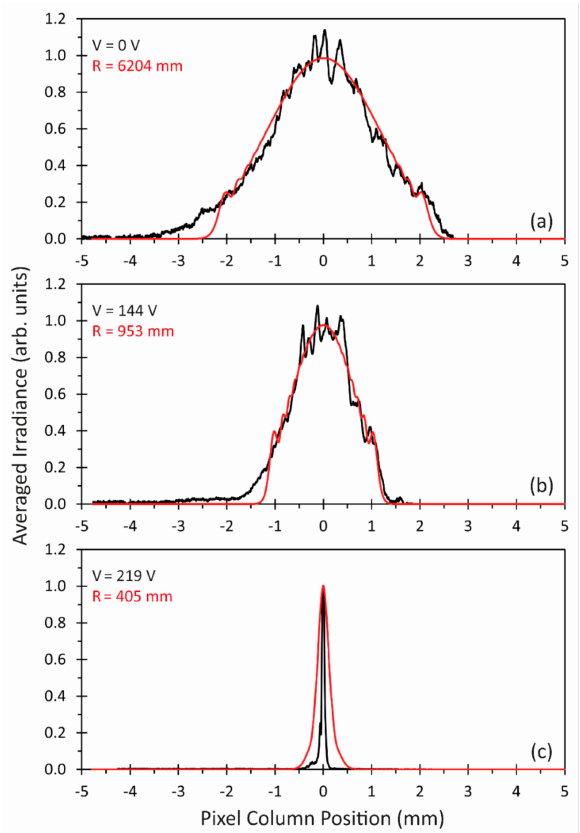
Figure 14. Pixel column averaged measured (black line) and simulated (red line) irradiances: ( a ) nearly collimated beam; ( b ) beam focus position behind the CMOS camera; ( c ) beam focus position near the camera